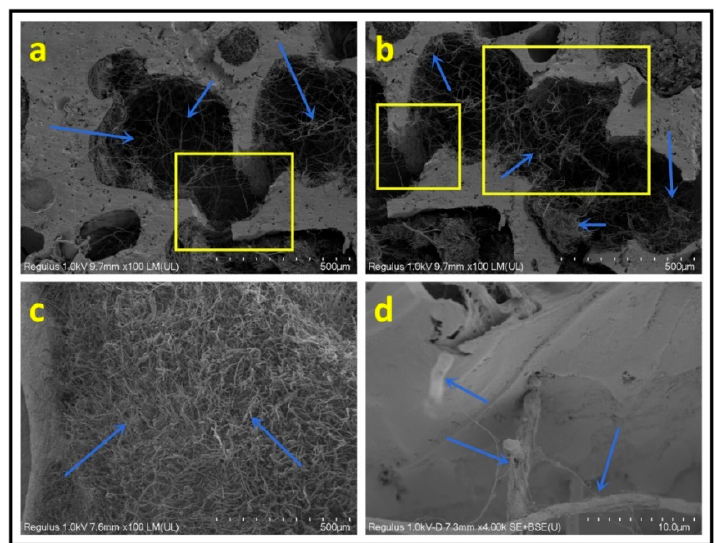
Figure 8. Optical images showing biodegradability of TSGFA-based foam: ( a ) activity development of Penicillium sp. over 30 days; ( b ) weight loss of the foam over 30 days.